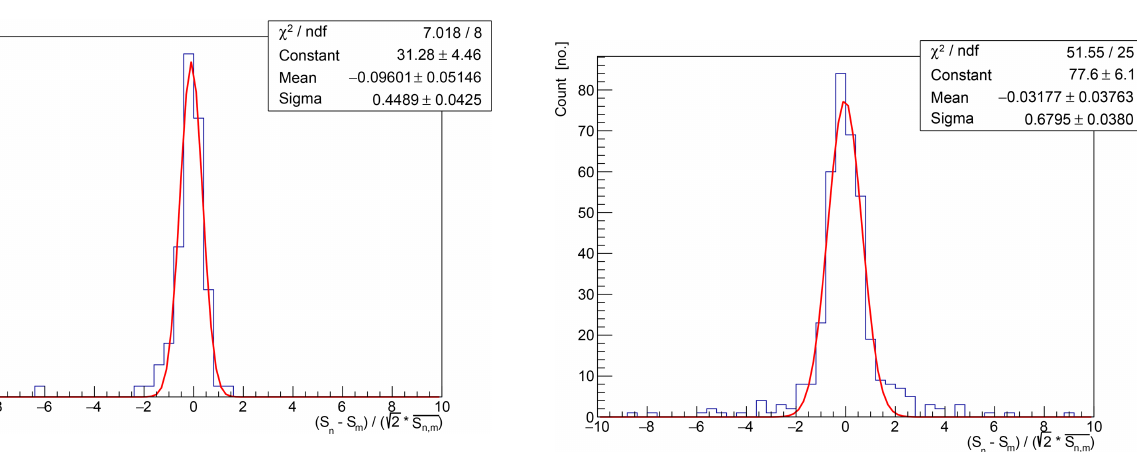
Figure 11. Histogram of the relative difference between measure- ments of hole pairs of the same distance for all